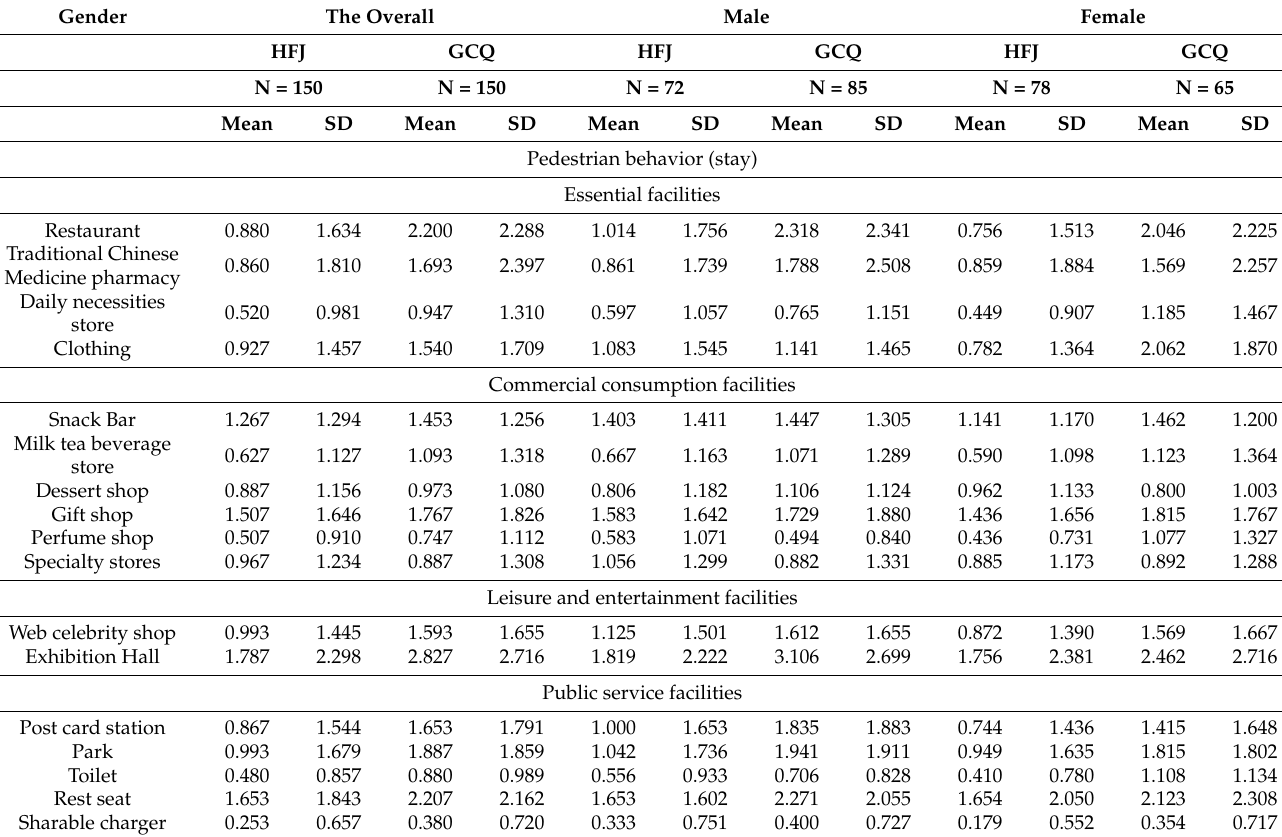
Table 3. Mean and standard deviation of dwell time for pedestrian street furniture of different